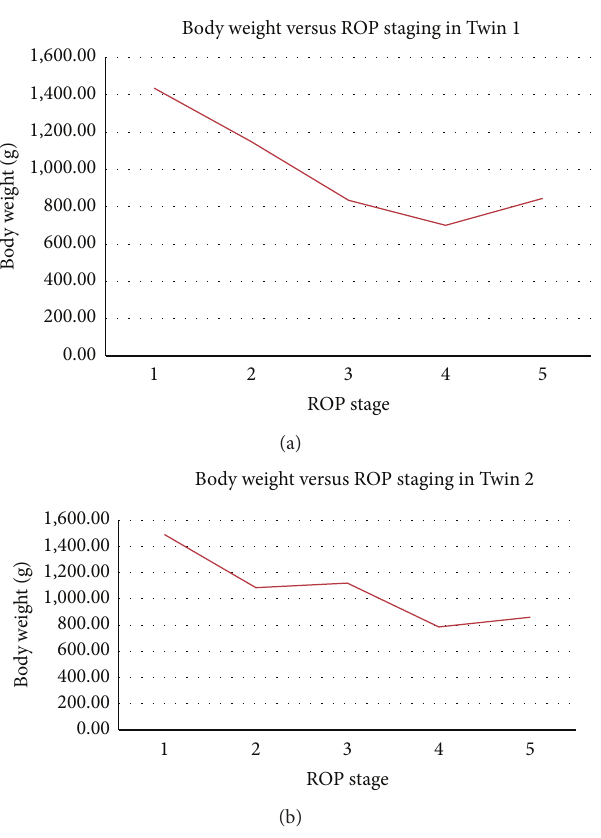
Figure 2: Body weight versus ROP stage in Twins 1 and